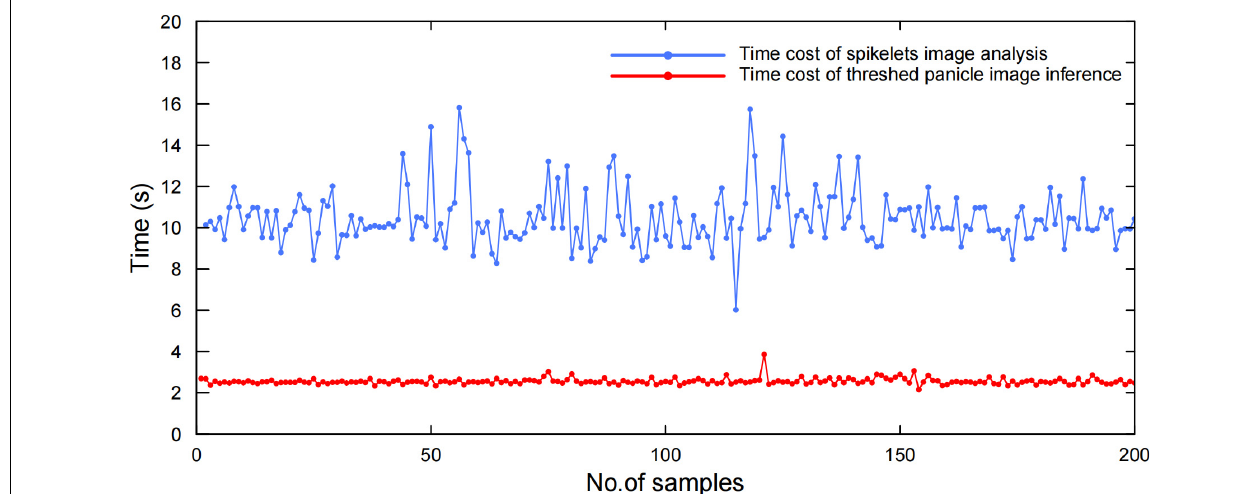
FIGURE 10 | Efficiency evaluation with 200 randomly selected panicle samples.